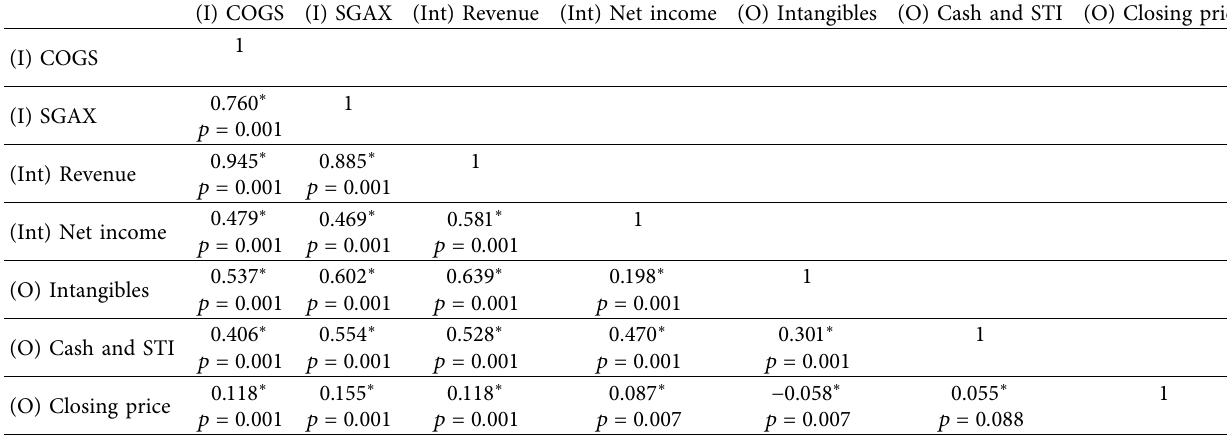
Table 3: Correlation